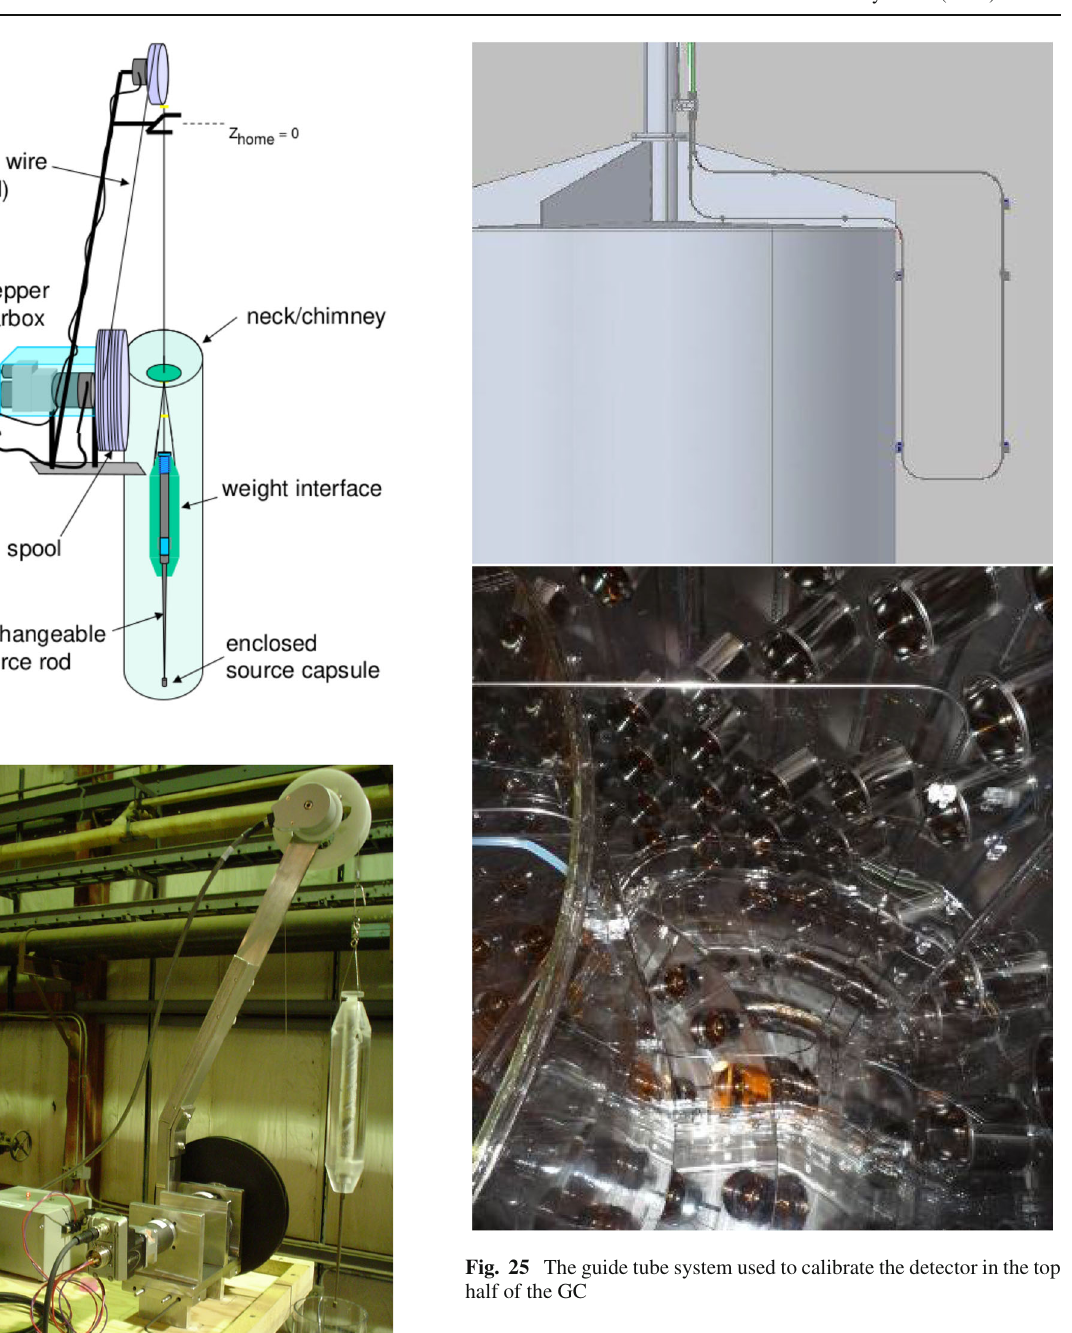
In the control box in the clean tent, the wire passed between two pulleys, one driven by a motor. A wheel encoder provided precise information on the wire position within the guide tube. Moreover, this component helped to keep the wire well aligned. A National Instruments USB-6212 DAQ mod- ule was optimized for fast sampling rates. It connected to a calibration laptop via the USB port and the system control was again via